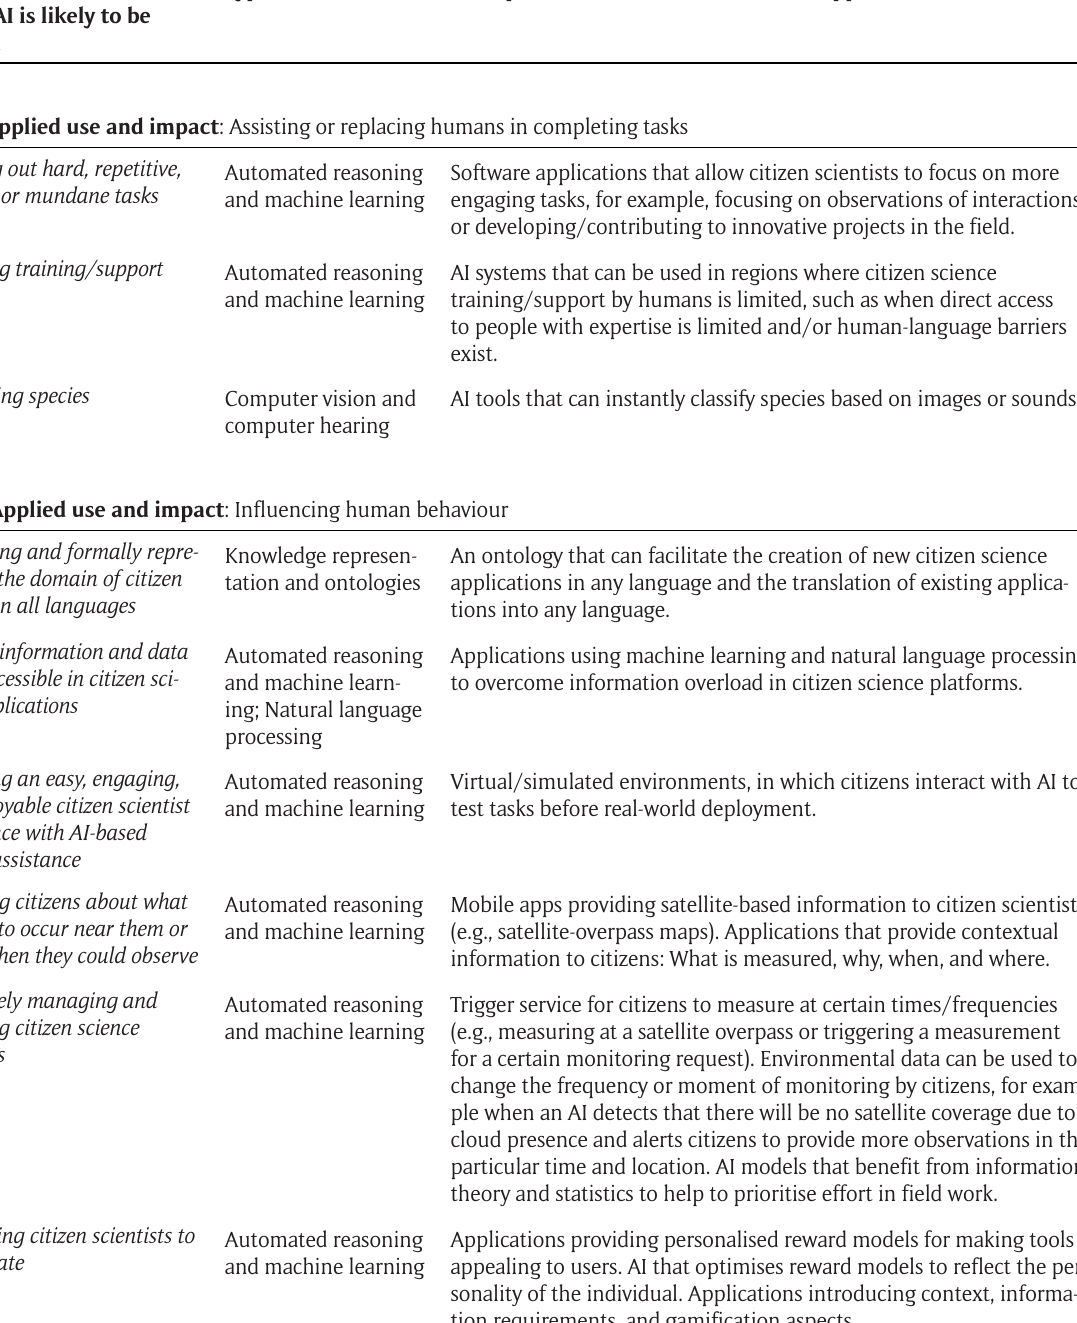
Table 2: Summary of new applications of AI in citizen science likely to appear in the near future. Description of instances where AI is likely to